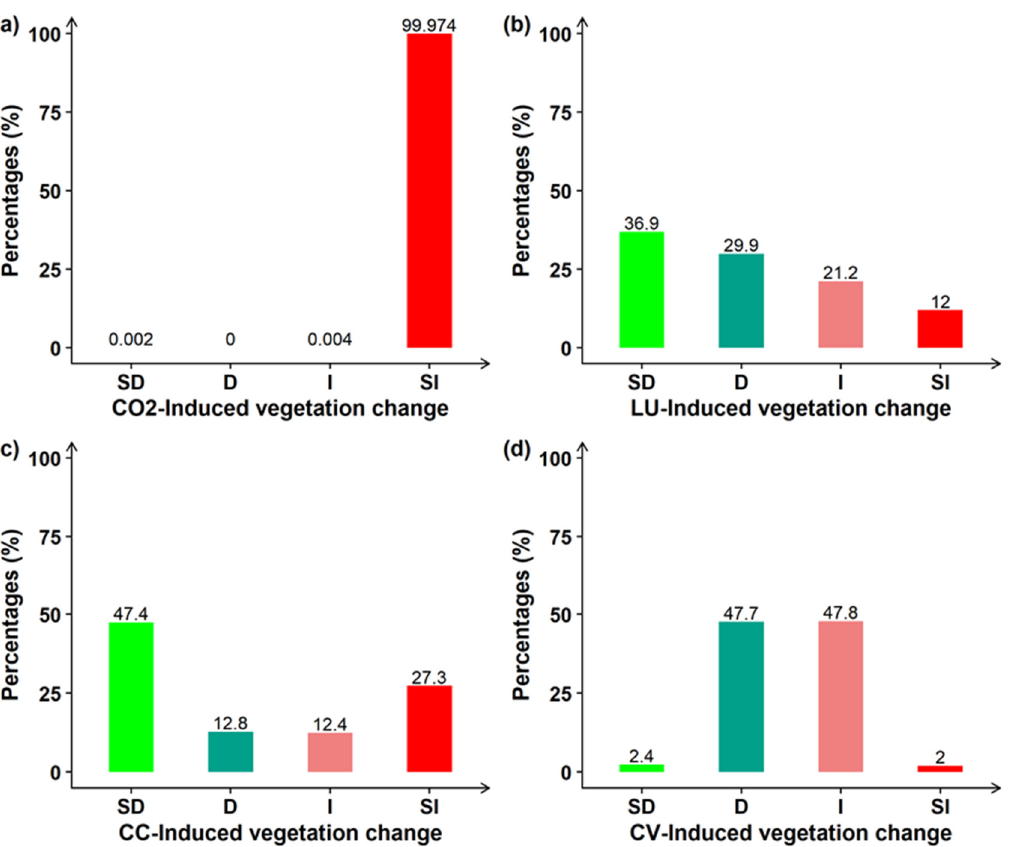
Figure 5. Percentages of grids with trends in a significant decrease (SD), decrease (D), increase (I), and significant increase (SI) caused by ( a ) CO 2 fertilization (CO 2 ), ( b ) land use (LU), ( c ) climate change (CC), and ( d ) climate variability (CV).